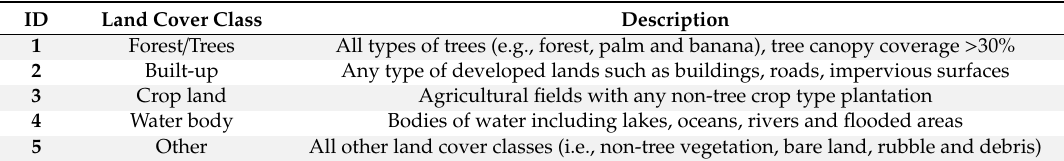
Table 2. Description of the selected land cover classes.